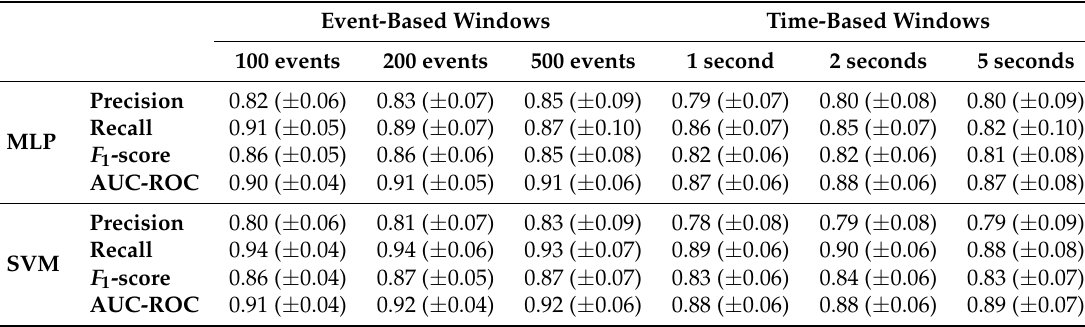
Table 1. Average and standard deviation